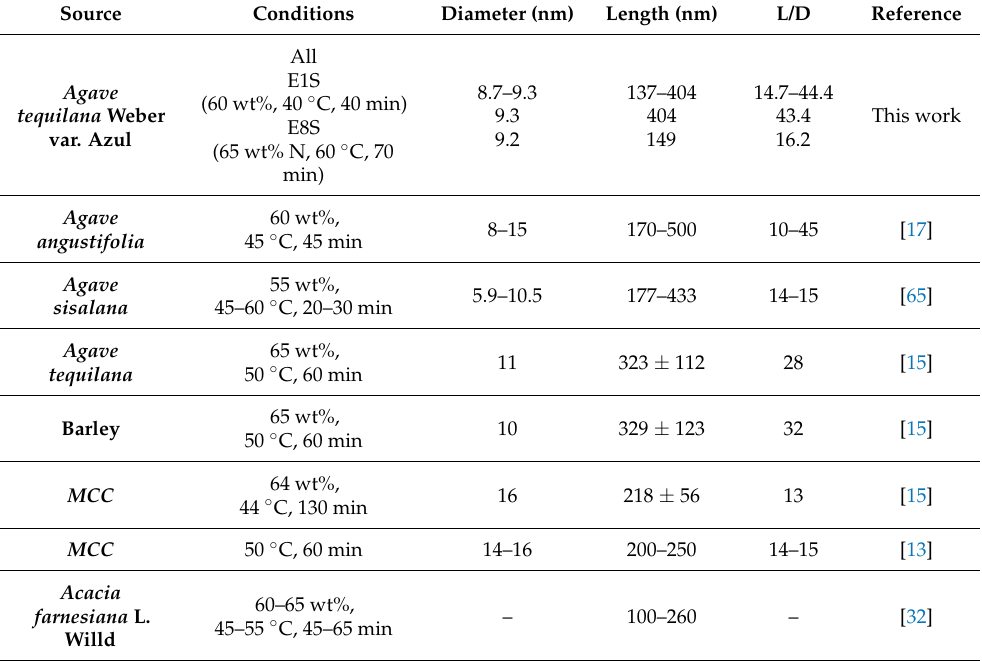
Table 6. Dimension comparison of CNC-S from different raw